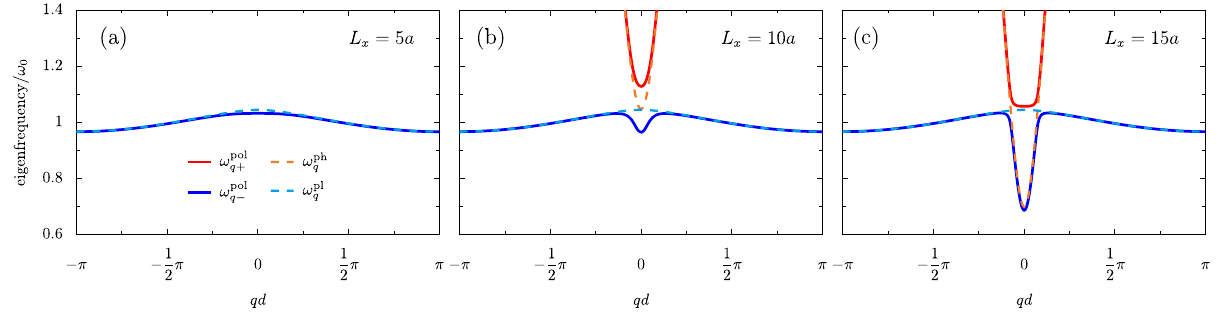
Figure 2: The polaritondispersion ω pol q τ inthe fi rst Brillouinzone([cf.Eq. (11))forthe cavityheights(a) L x = 5 a , (b) L x = 10 a ,and(c) L x =15 a .The upper (lower)polaritonswith τ = + ( − ) are denoted by solid blue(red) lines. The uncoupled photonic (dipolar) dispersions ω ph q ( ω dp q ) are shown as dashed cyan (orange) lines (cf. Eqs. (5) and (3)). In the fi gure, the interdipole separation d = 3 a , the dipole strength ω 0 c / a (cid:1) 1 / 10, and the cavity aspect ratio L y = 3 L x are